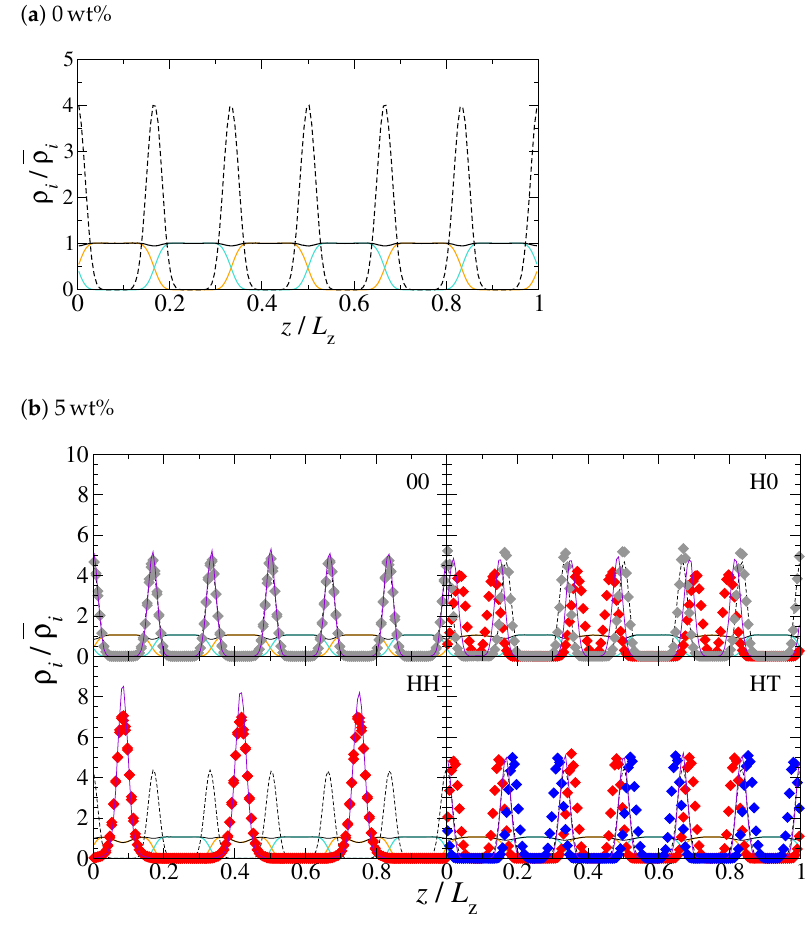
Figure 3. Density profiles of the pristine polymer ( a ) and the systems with 5 wt% particle mass fraction ( b ) in the z direction. The density profiles of h-block, t-block, chain beads and chains’ centre of mass are, respectively, indicated by orange, cyan, solid black and dashed black curves. The density profiles of H-like, T-like and neutral ND beads are represented as solid diamonds in red, blue and grey, respectively, and those of the NDs’ centre of mass as violet solid